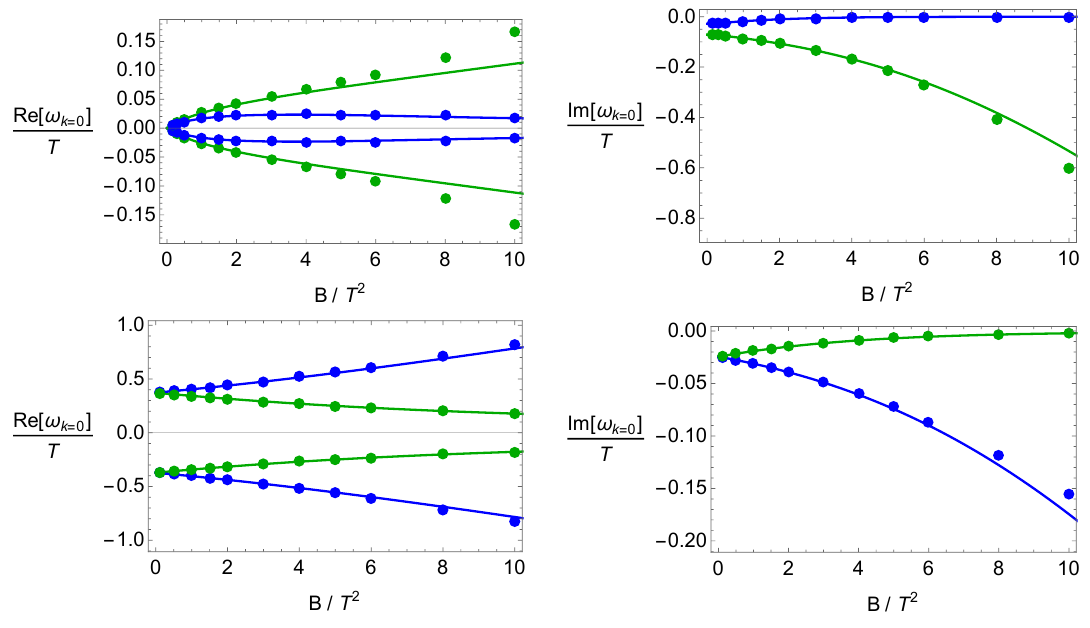
Figure 12 . The real and imaginary part of the first non-hydrodynamic modes at density µ/T = (0 . 5 , 5) (upper panels, lower